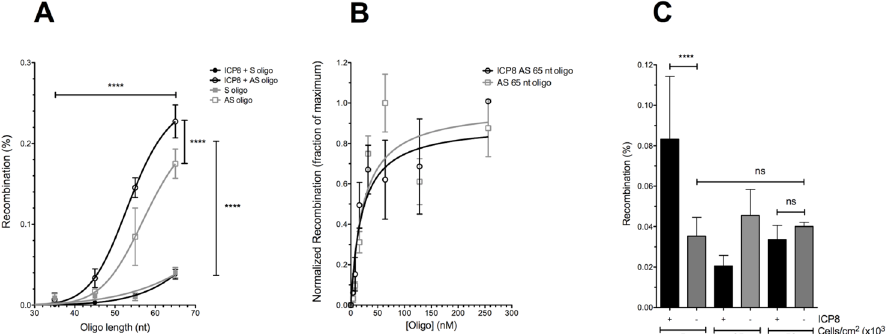
Fig 5. Optimization of human cell recombineering. During the course of developing this platform for human cell recombineering by ICP8, the frequency of gene targeting varied by 10 to 20 fold, influenced by the design and concentration of the oligo substrate, as well as the cell density in the well during oligo transfection. A) ICP8 and endogenous recombination was significantly improved by longer and antisense oligos . 293T-Yellow cells were sequentially transfected with pCMV-ICP8 and with oligos that donate the sequence for converting Yellow to Green fluorescence. Recombination was measured as a function of oligo size and the targeted strand. AS oligo indicates that the oligo corresponds to the antisense strand of eGFP Y203 and S oligo indicates that the oligo corresponds to the sense strand of eGFP Y203 . The no oligo background for 293T or 293T-pCMV-ICP8 was subtracted from each data point and never exceeded 0.004%. Fisher’s Exact Test was used to evaluate statistical significance with (cid:3)(cid:3)(cid:3)(cid:3) indicating P < 0.001; n = 3. Recombination rates as a function of oligo length could be fit to a one site binding equation (site size 10 nucleotides) with a Hill slope parameter based on previous knowledge of the cooperativity of ICP8 binding to DNA [26].B) Recombination rates improved as a function of oligo concentration. The effect of oligo concentration on gene targeting was evaluated from 4 to 256 nM. Recombination with oligo 85 was measured in pSLIK4 and pSLIK6 cell lines induced with 1 μ g/ml doxycycline as a function of oligo concentration. Recombinants were quantified by flow cytometry, normalized to the maximum value for each cell line and fit to a one site binding equation (site size 10 nucleotides) that accounts for depletion of free recombination proteins at saturating oligo concentration. C) ICP8 requires replicating cells. In the course of these studies, it became evident that some of the fluctuation in recombination rates observed was due to differences in the density of cells plated before addition of oligos. Recombination with 50 nM antisense oligo 85 was measured in pSLIK4 and pSLIK6 cell lines induced with 1 μ g/ml doxycycline and plated at densities of 5000, 25000 and 50000 cells per cm2. Recombinants were quantified by flow cytometry. Fisher’s Exact Test was used to evaluate statistical significance with (cid:3)(cid:3)(cid:3)(cid:3) indicating P < 0.001 and ns indicating P > 0.05;n =